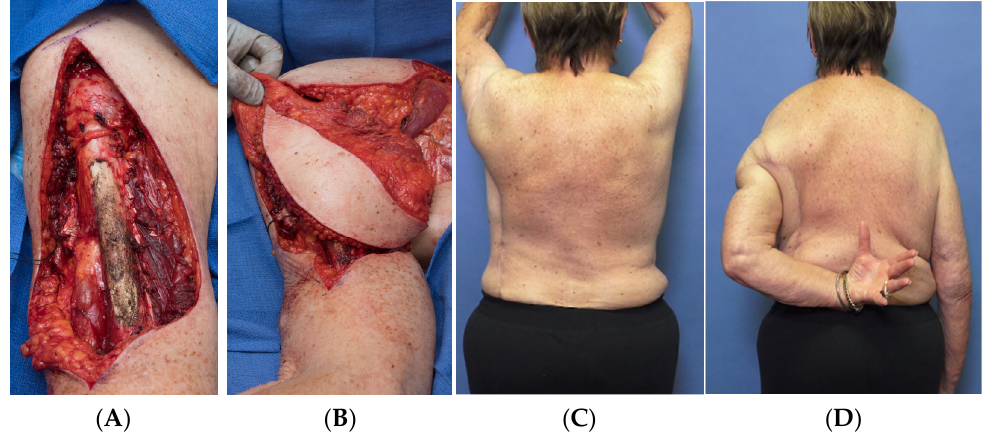
Figure 2. Following resection of the deltoid ( A ). The pedicled latissimus flap is elevated. ( B ) Inset to allow for active shoulder elevation. ( C ) Internal rotation ( D ).